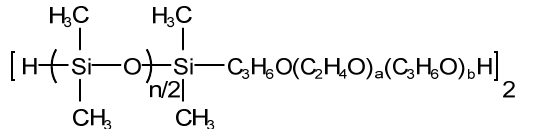
Figure 7. Structure of PESO.